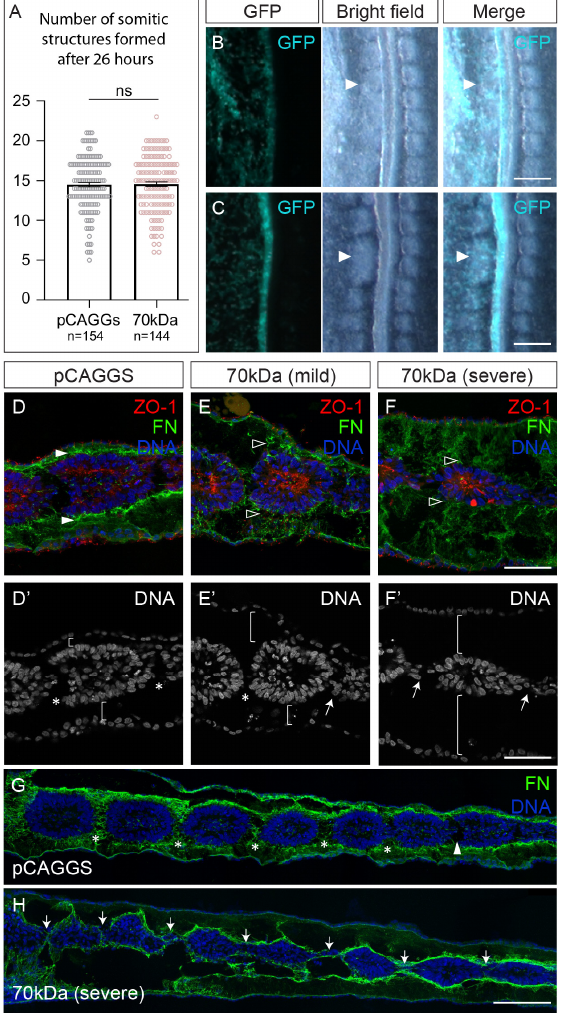
tissues (Figure S2A,B), which are reminiscent of the phenotypes obtained after interfering with fibronectin matrix deposition and/or with fibronectin–integrin binding [3,63–66].